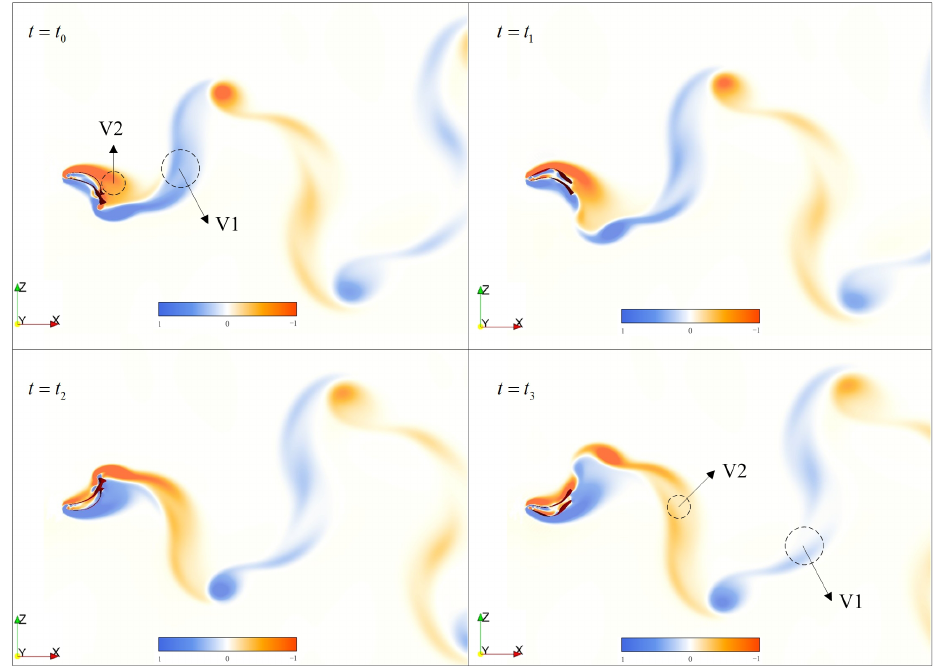
Figure 11. Time evolutions of the vortical structures of two side-by-side flapping plates at G z =